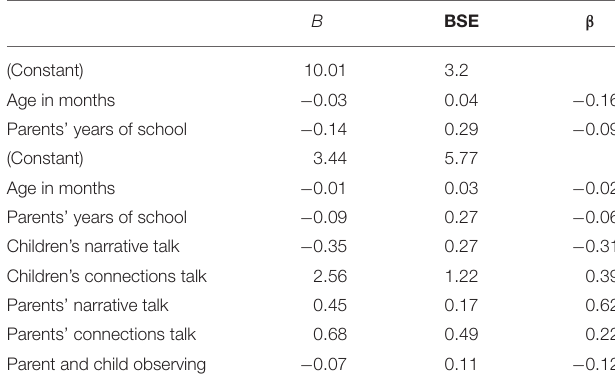
TABLE 5 | Hierarchical regression: predictors of children’s explanatory science talk at the fossil and replica bone exhibits.